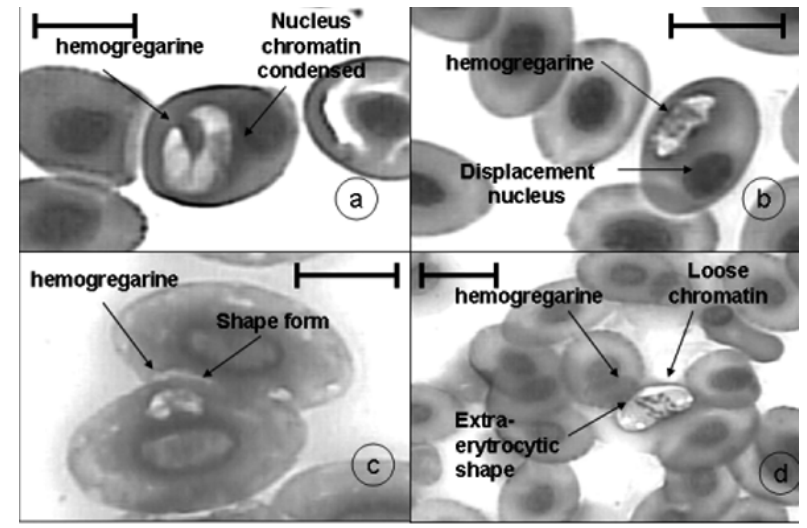
Fig. 2 – Gamont of hemogregarine in a blood smear: a) hemogregarine from Leptodactylus podicipinus ; b) hemogregarine from Leptodactylus chaquensis ; c) hemogregarine from Phyllomedusa hypocondrialis ; d) hemogregarine extraerythrocytic from L. podicipinus . Scale bar = 10 μ m. Giemsa stained thin blood